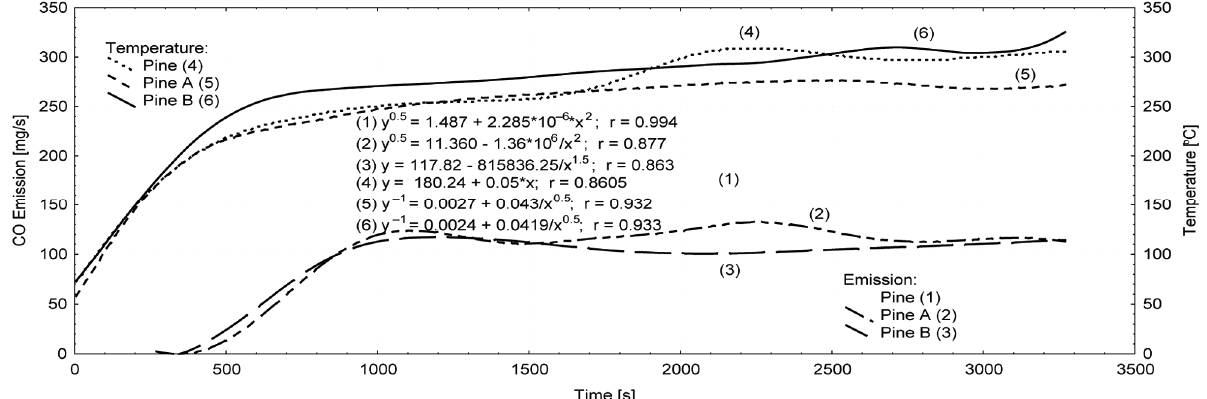
Fig. 6. Average emissions of CO from tested specimens and alternation of average temperature on the surface of tested specimens 2 affected by heat sources of 10 kW/m subjected to time: (1) – non-treated pine timber specimens; (2) – pine timber specimens